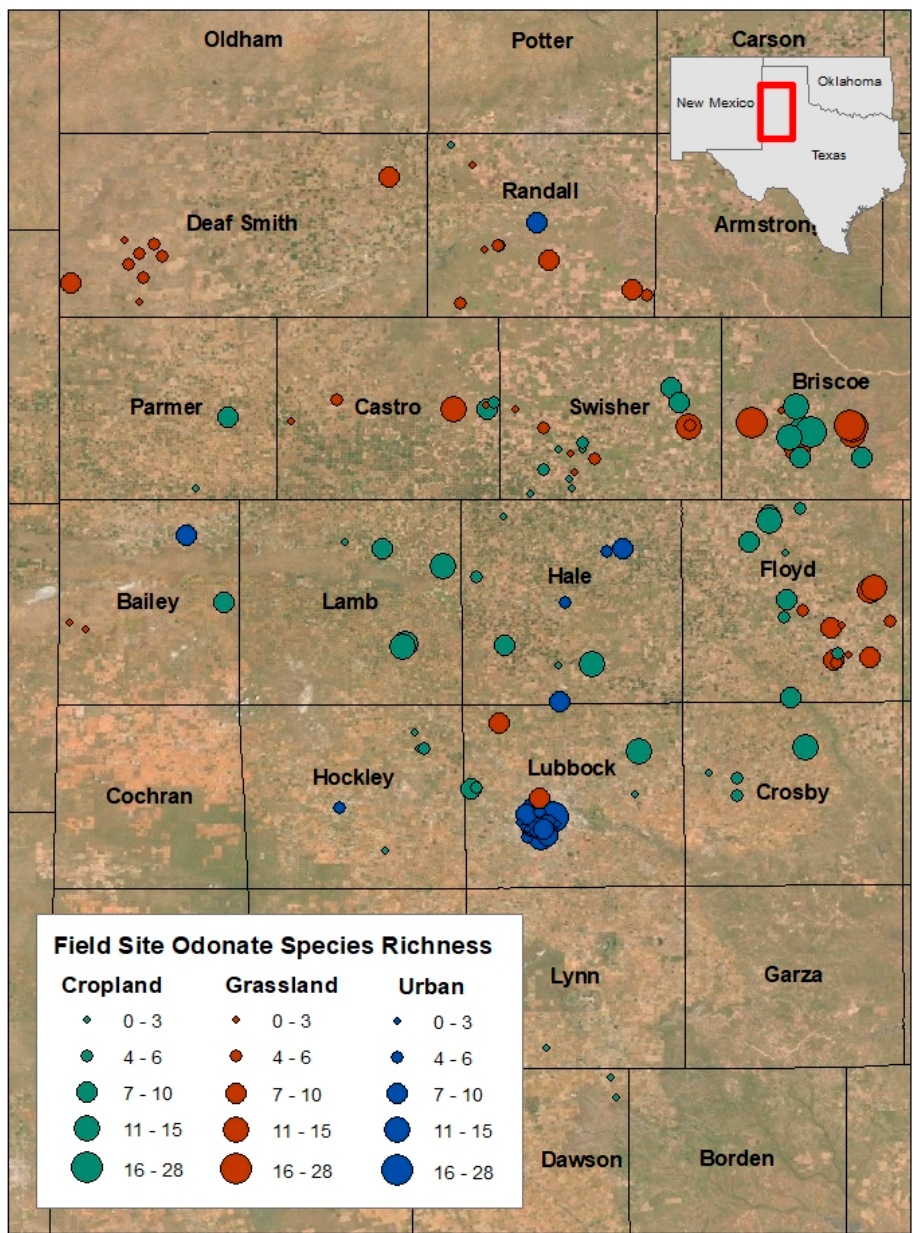
Figure 3. Map of field study sites by surrounding land use/land cover type, with symbols sized commensurately to odonate species richness across the Texas panhandle (United States), 2003–2020; categories were based on natural breaks in the data. Basemap layer from Esri (Redlands, CA, United States).